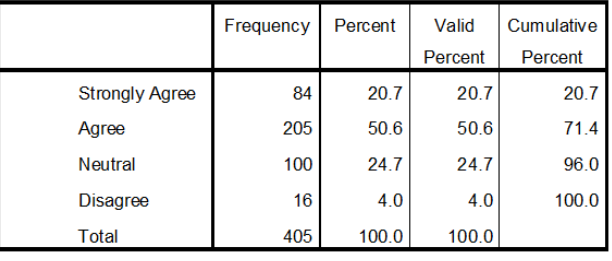
Figure 27. As our technology and business objectives are clear and well defined, we are able to deliver products quickly